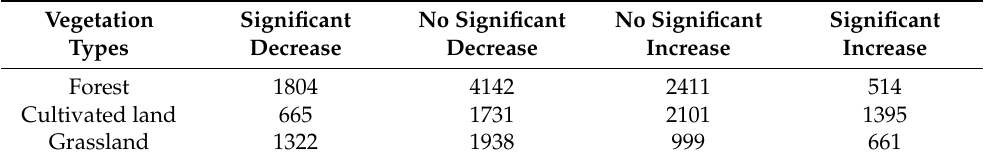
Table 5. Pixel numbers containing different trends in SOS of three vegetation types in northeast China for 1982–2014 (5% significance level).